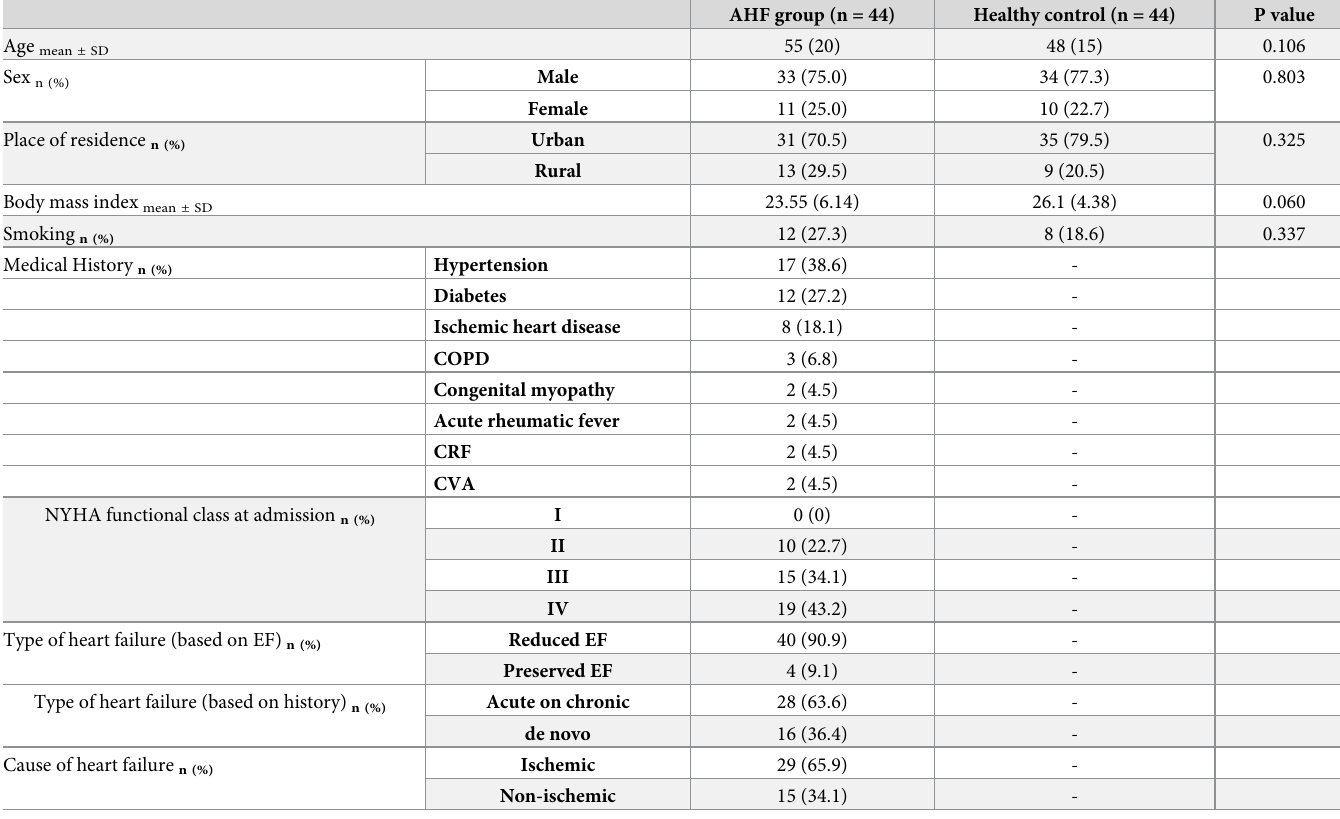
Table 1. Baseline characteristics of groups of acute heart failure patients and healthy